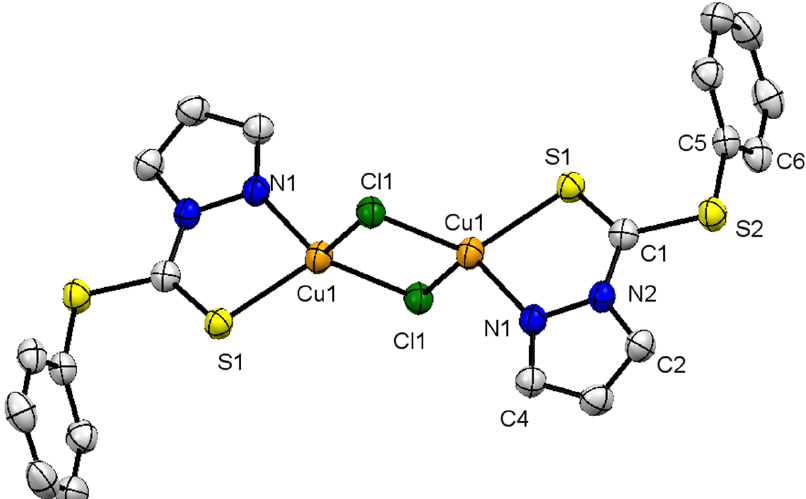
Figure 1. X-ray single-crystal structure of compound 1; partial numbering scheme for carbon and non-carbon atoms, ellipsoids drawn at 50% probability level, all hydrogen atoms are omitted for clarity. Color scheme: Cu = orange; Cl: green; S = yellow; and N = blue. Selected structural features: bond lengths (Å) and angles (°); Cu(1)-N(1) 2.057(2), Cu(1)-S(1) 2.287(7), Cu(1)-Cl(1) 2.318(7), Cu(1)- Cl(1) 2.325(7), S(2)-C(1) 1.749(3), S(2)-C(5) 1.770(3), S(1)-C(1) 1.637(3); N(1)-Cu(1)-S(1) 85.44(6), N(1)-